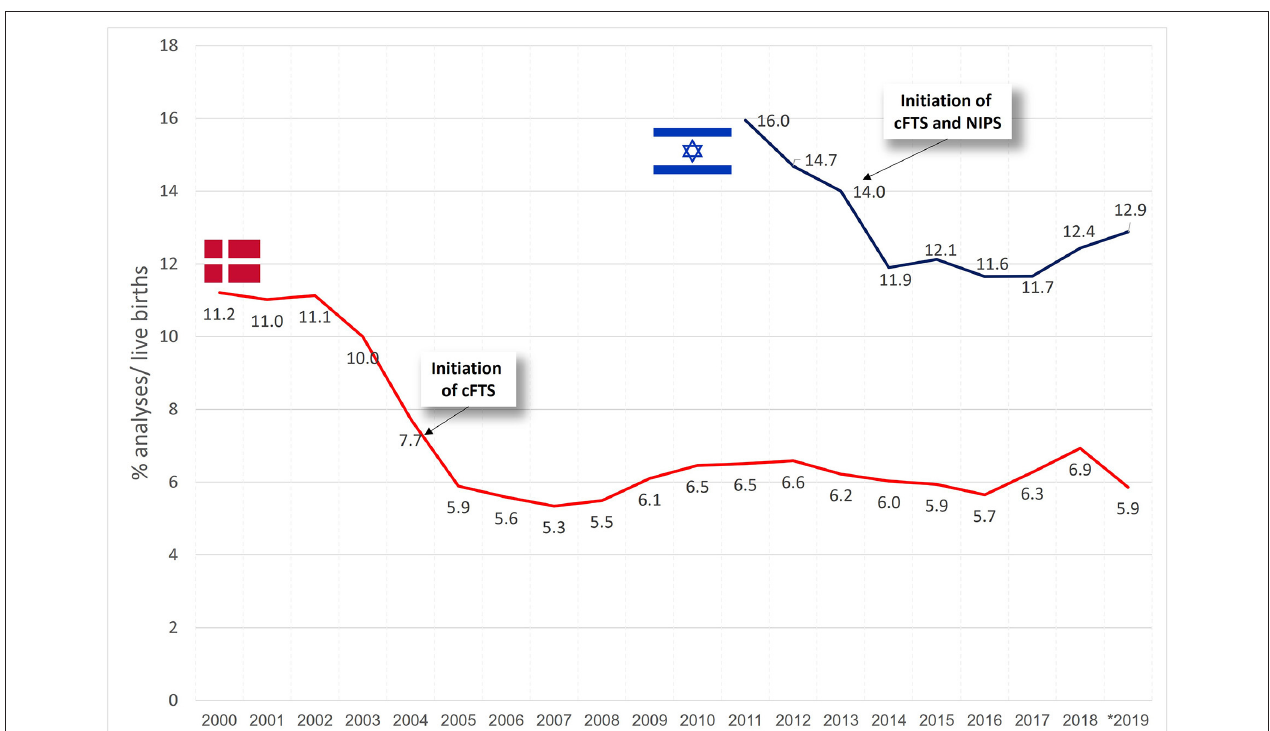
FIGURE 2 | Trends in the uptake of invasive tests in % of live births in Denmark and Israel.